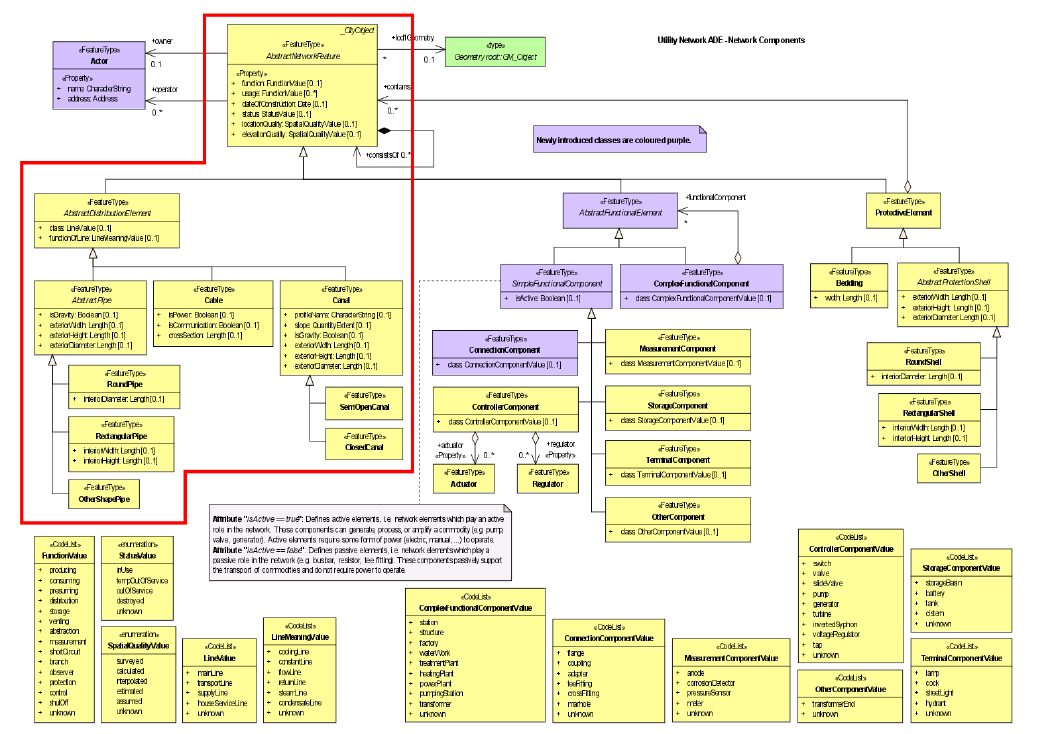
Figure 1. UML diagram of the Utility Network ADE Network components [45]. The highlighted area depicts the elements used for rendering and